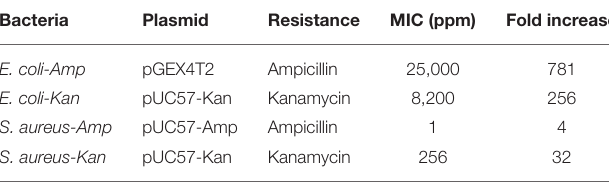
TABLE 2 | Minimum inhibitory concentrations of transformed bacteria